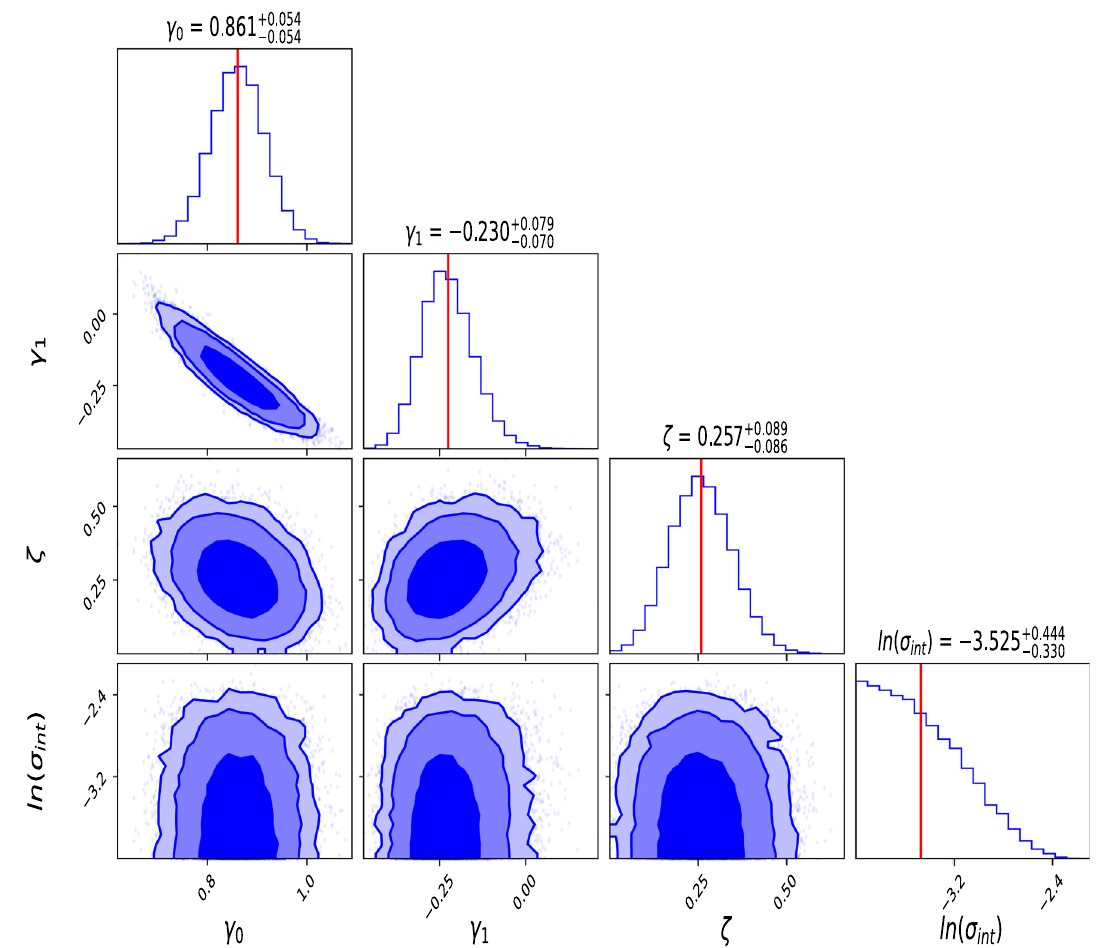
Fig. 7 Marginalized credible intervals (68%, 95%, 99%) for γ 0 , γ 1 , ζ , and ln (σ int ) for the SPT-SZ dataset. The parameter ζ encodes the variation of the gas depletion factor as a function of M 500 (cf. Eq. (12))